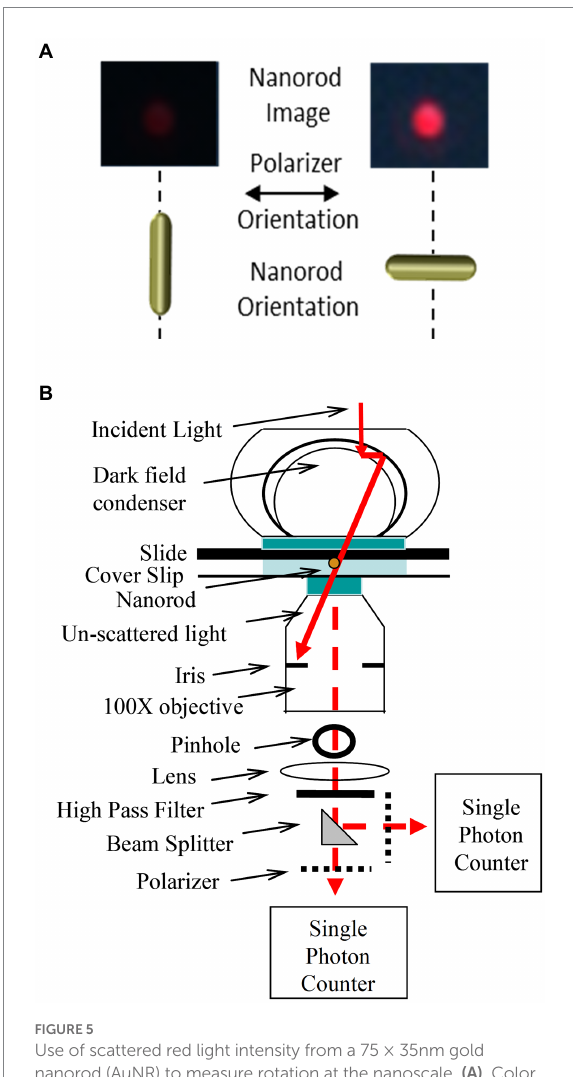
FIGURE 5 Use of scattered red light intensity from a 75 × 35 nm gold nanorod (AuNR) to measure rotation at the nanoscale. (A) . Color image of AuNR-scattered light viewed by dark-field microscopy through a high pass filter to eliminate all but red light and a polarizer filter when the long axis of the AuNR is perpendicular and parallel to the plane of polarization. (B) . Dark-field microscope design to record changes of scattered red light intensity vs. time from a single AuNR capable of determining the direction of rotation using a beam splitter to divert half of the photons through a second polarizer set at a rotational position that will reach a maximum light intensity before the first if the AuNR is rotating counterclockwise (CCW). This figure has been modified from that in Hornung et al.